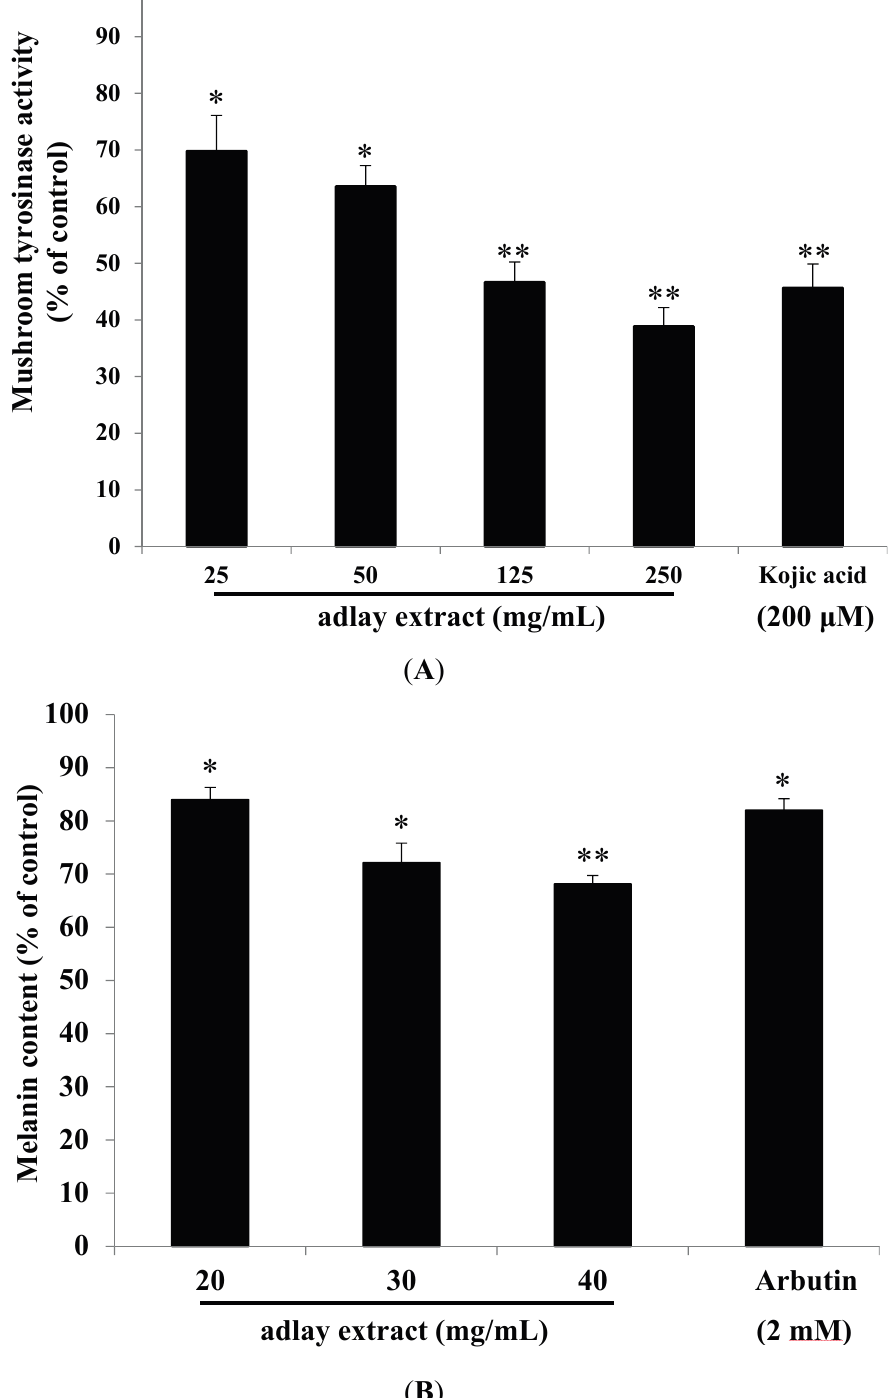
Figure 1. The inhibitory effects of adlay extract on melanogenesis. ( A ) The effects of adlay extract on mushroom tyrosinase activity; ( B ) The effects of adlay extract on melanin content in B16F10 cells; ( C ) The effects of adlay extract on tyrosinase activity in B16F10 cells. The results are presented as percentages of the control, and the data are presented as the mean ± S.D. of three separate experiments. Black bars and lines on each bar indicate the mean and standard deviation. The values are significantly different compared with the control. * p < 0.05, ** p <